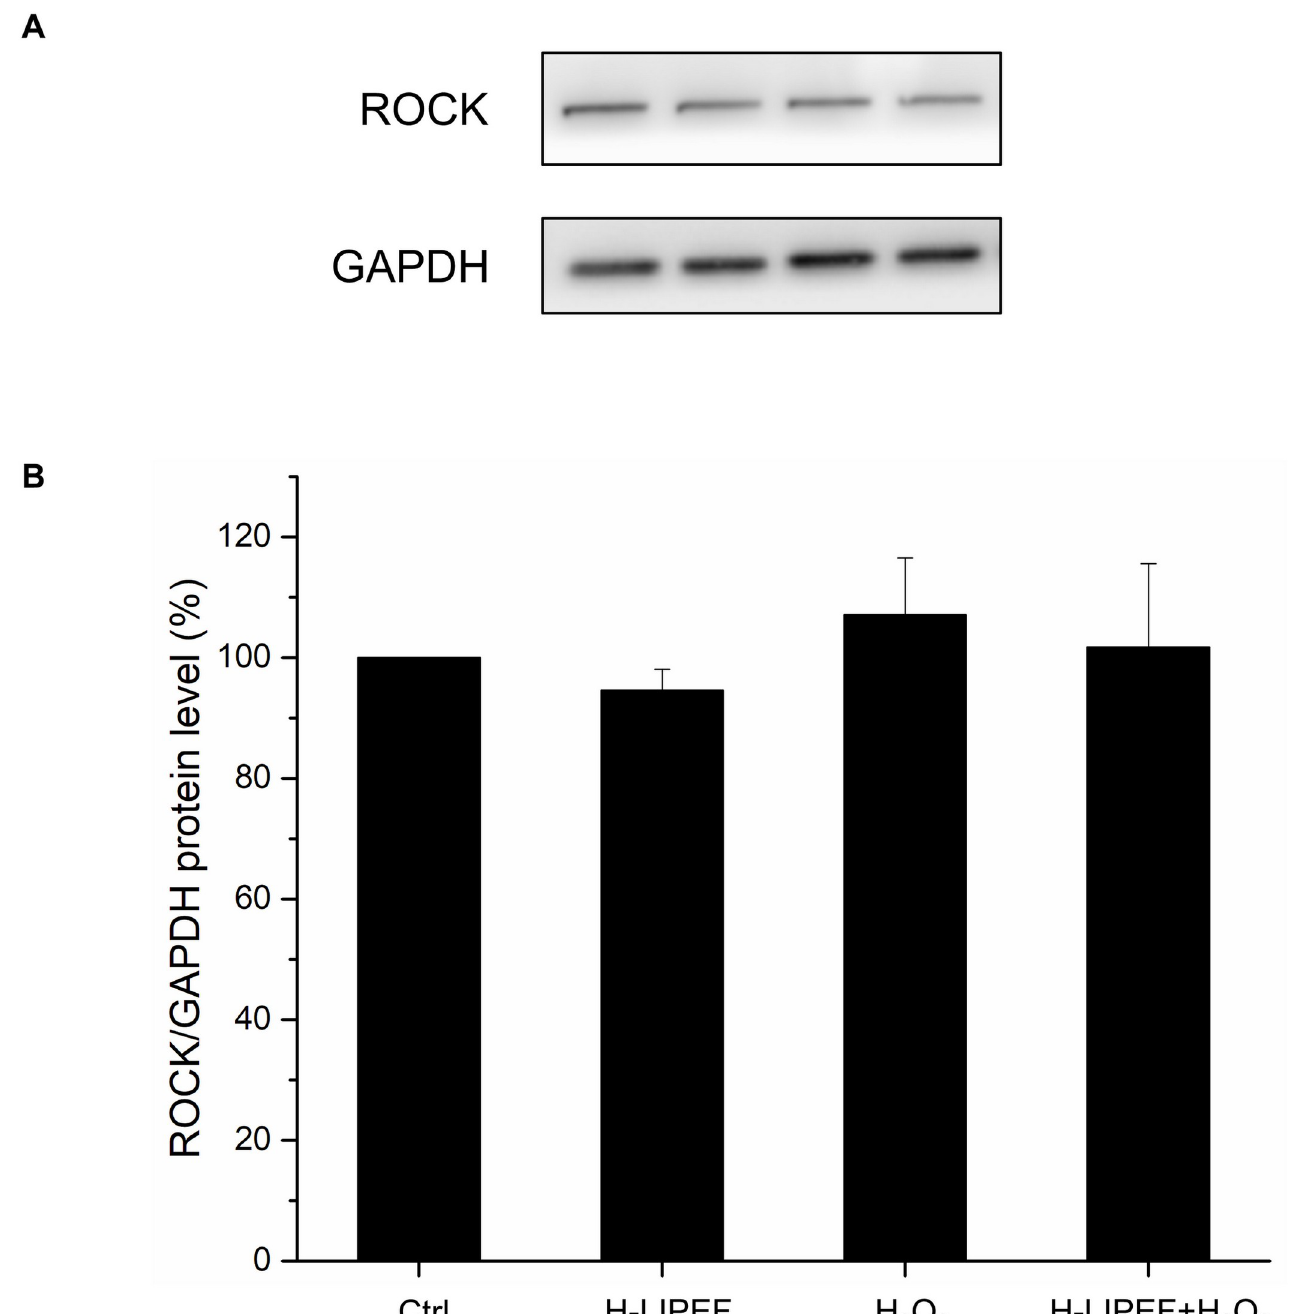
Fig 8. Effect of H-LIPEF on expressions of ROCK protein in SH-SY5Y cells. (A) Western blot analysis of ROCK protein expressions. (B) Quantification of ROCK expression level after H-LIPEF, H 2 O 2 , or H-LIPEF+H 2 O 2 treatment. The expression levels were normalized to GAPDH and each relative expression level was compared with control. Data represent the mean ± standard deviation (n =